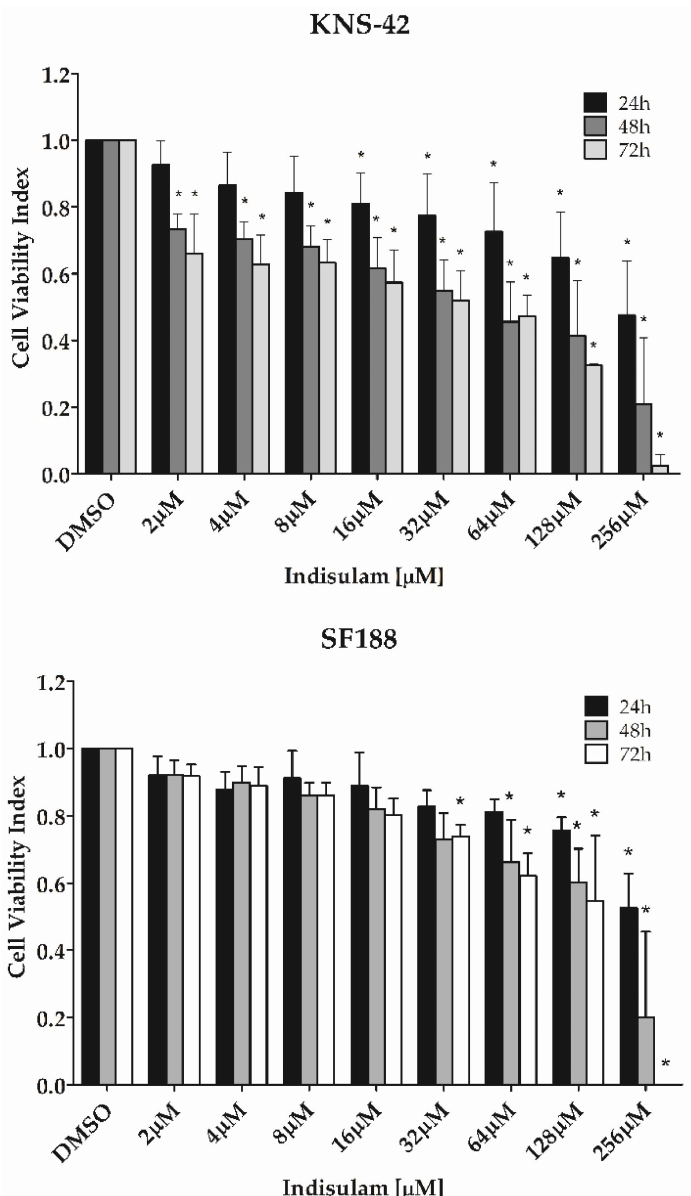
Figure 3. Indisulam decreases cell viability in pHGG cell lines. To chemically induce hypoxia, SF188 and KNS-42 cell lines were pre-treated with CoCl 2 (50 µ M and 100 µ M, respectively) for 24 h. After hypoxia induction, the cells were treated with increasing concentrations of Indisulam (0–256 µ M) for 24 to 72 h. The cell viability was quantified by the resazurin method. The plot shows the mean ± standard deviation of three independent experiments. * p < 0.05 indicates a significant difference between the treated cells and the DMSO vehicle